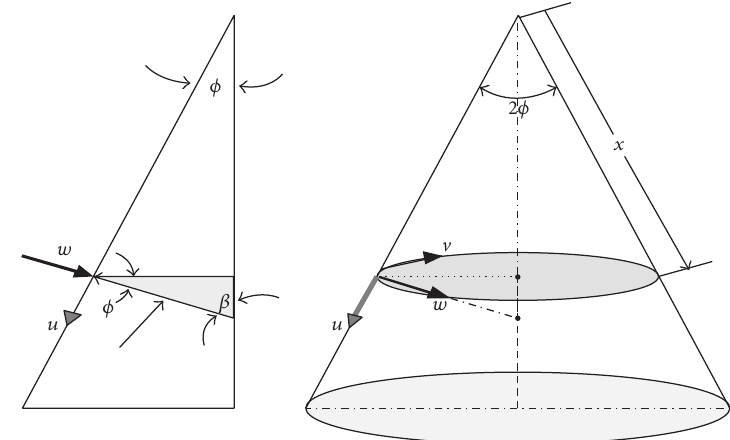
Figure 1: Geometry and coordinate system of a conical